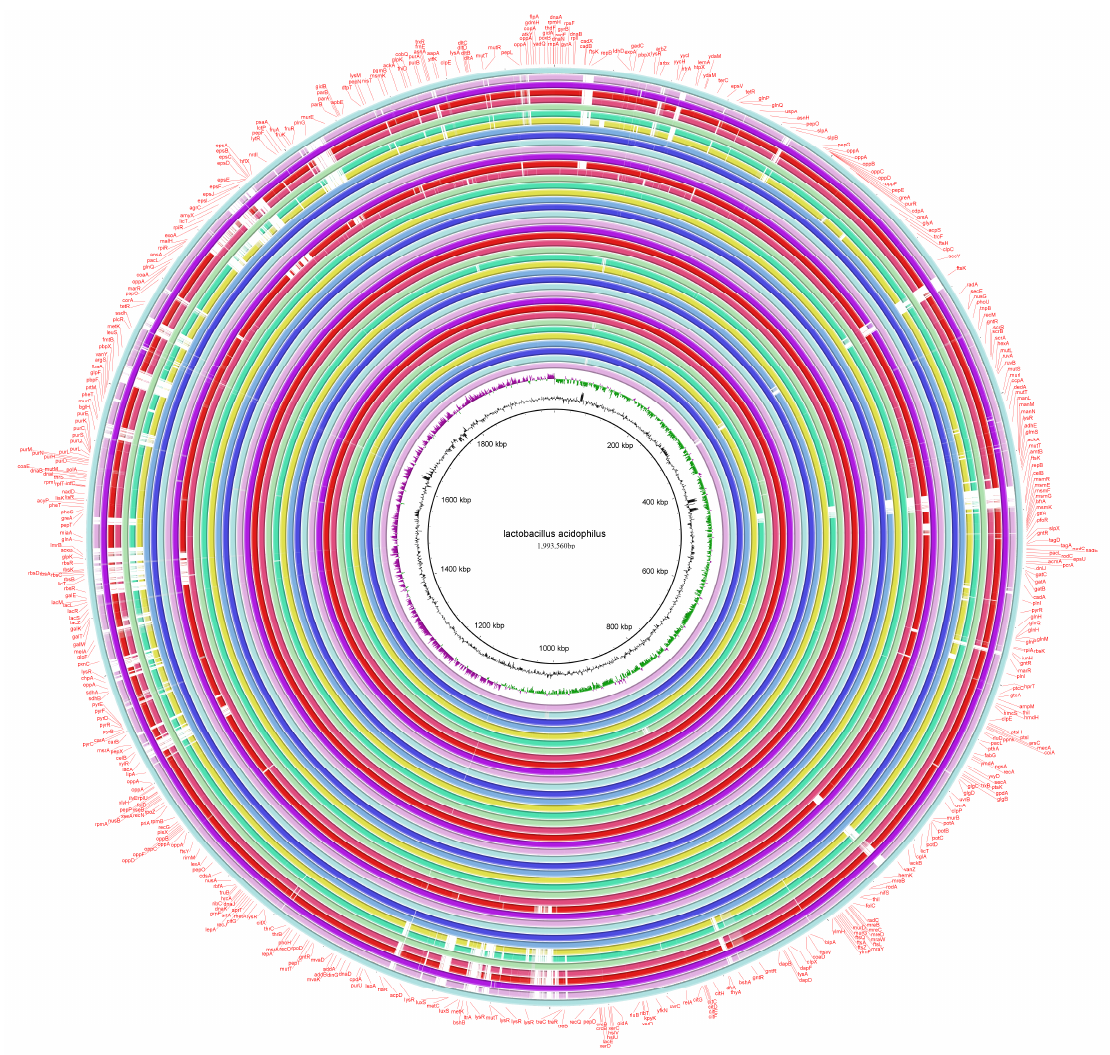
Figure 5. The whole genome comparison of L. acidophilus .